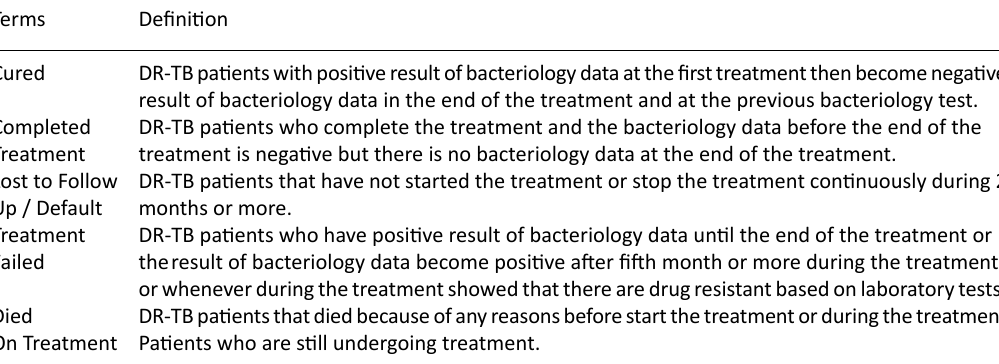
Table 1. Definitions of TB Treatment Outcome at DR-TB Patients